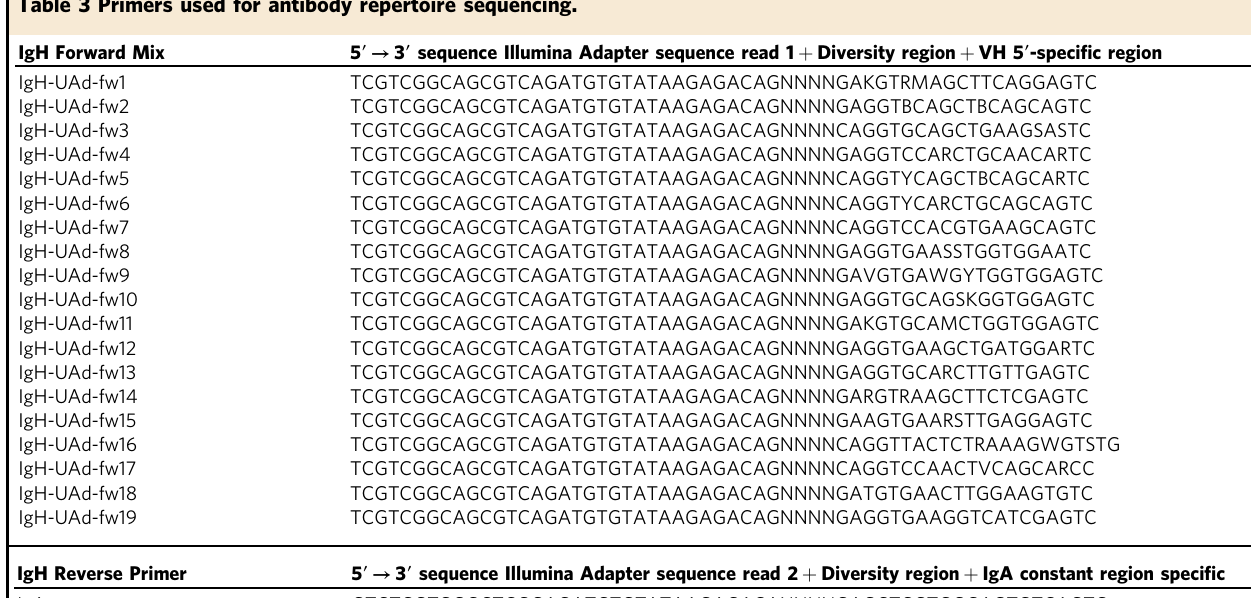
Table 3 Primers used for antibody repertoire